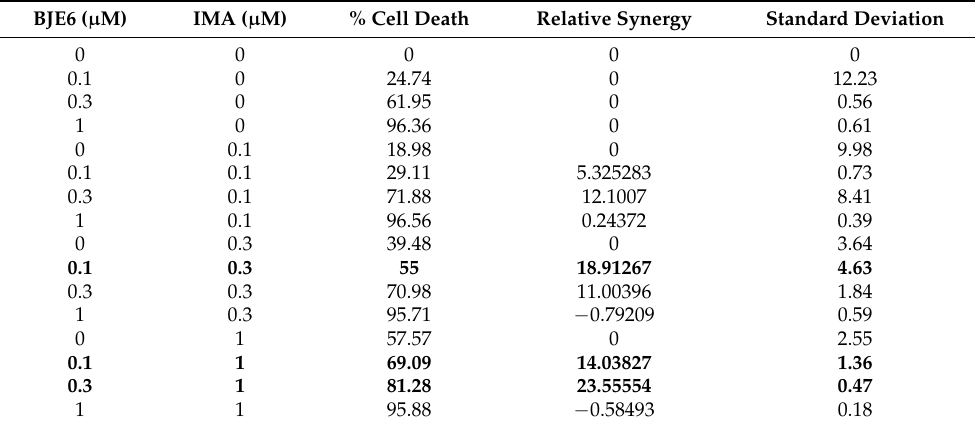
Table 1. Relative synergy of BJE6 and IMA for K562 cells calculated from data obtained and shown in Figure 2D. Best relative synergy in